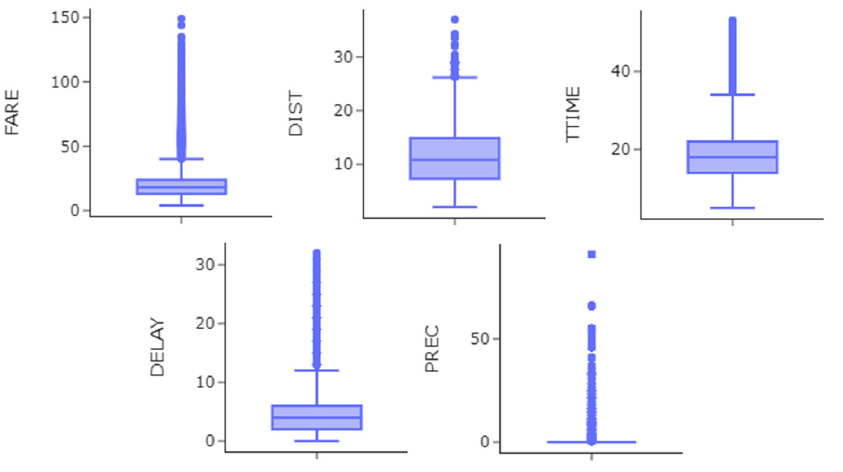
Figure 3. Boxplot of continuous variables.